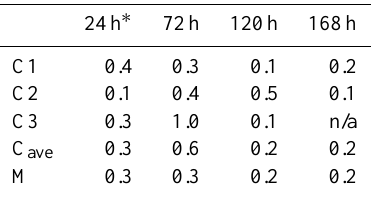
Table 5. Measured and modelled export flux of Fe (mgm − 2 d − 1 ) under control conditions. C1–C3 stand for the triplicate CONTROL-meso, C ave for the mean of C1–C3 and M for model results. Numbers are averaged fluxes in the time periods after dust addition in